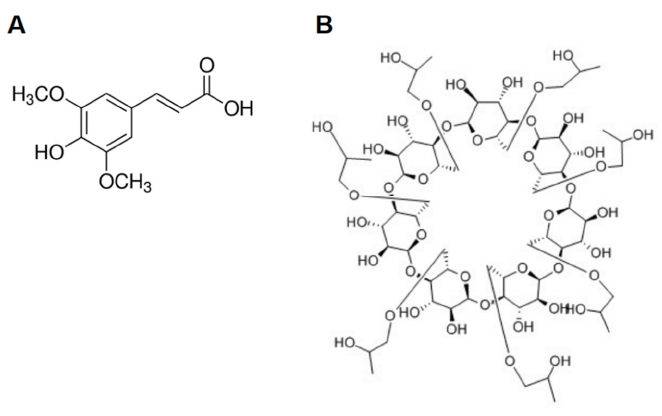
Figure 1. The chemical structure of ( A ) SA and ( B ) HPβCD.